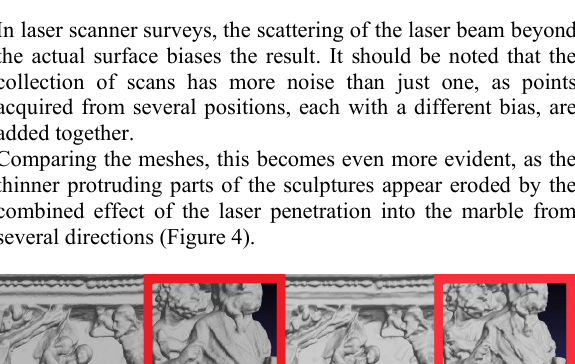
Figure 3: Section of point clouds of a capital, acquired with Z+F 5010C and Leica C10.